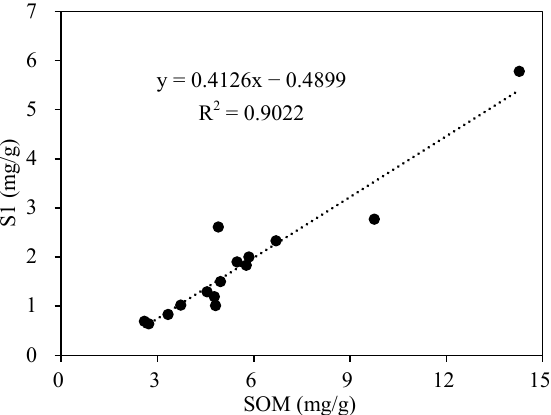
Figure 2. Correlation between the soluable OM and free hydrocarbon S1 content.